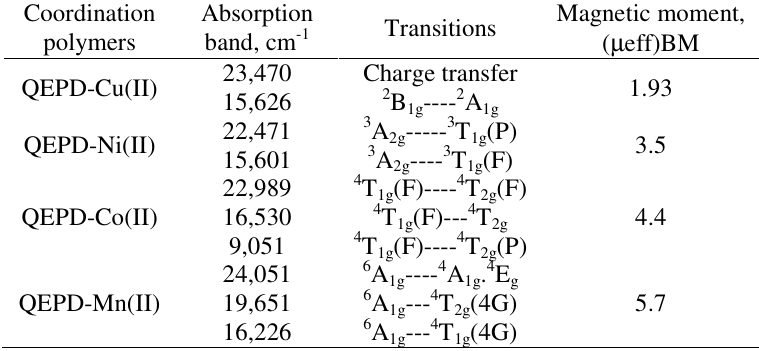
Table 3. Reflectance spectral and magnetic moment data of the QEPD coordination polymers.